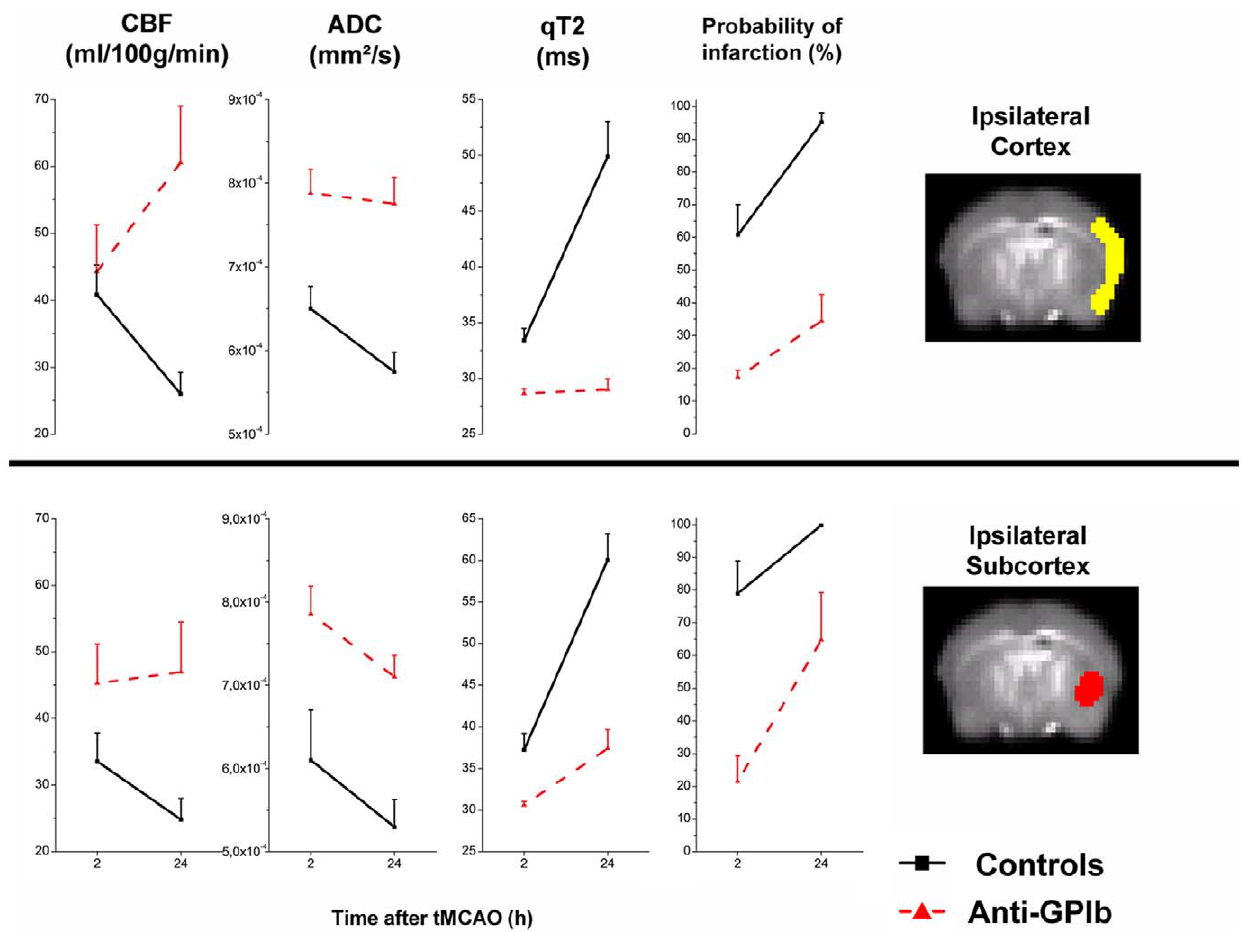
Figure 5. Plots of all outcome measures within cortical (upper half) and subcortical (lower half) ROI’s per group and time point. Control mice after t MCAO (solid black lines) and anti-GPIb treated mice (dashed red lines) showed significant group differences in the postischemic course of CBF (first column): sustained reperfusion in anti-GPIb treated mice vs. progression of hypoperfusion in controls, which was most marked in the cortex (Interaction GROUPxTIME; p=0.00001). This effect of CBF was paralleled by a decrease in cortical and subcortical ADC in controls, but stable cortical ADC in anti-GPIb treated mice and less severe subcortical ADC decrease in anti-GPIb treated mice as compared to controls (second column). The third column (qT2) indicated severe increase in the cortical and subcortical T2 relaxation constant over time reflecting the demarcation of irreversible tissue damage for controls. In contrast, anti-GPIb treated mice exhibit stable T2 values in the cortex protected from infarction and in the subcortex exhibit only moderate increase in mean T2 as compared to control mice consistent with a lower group probability of infarction in this region. Probability of infarction (fourth column) by automated segmentation of individual animals is consistently lower for anti-GPIb treated mice, a finding most marked in the